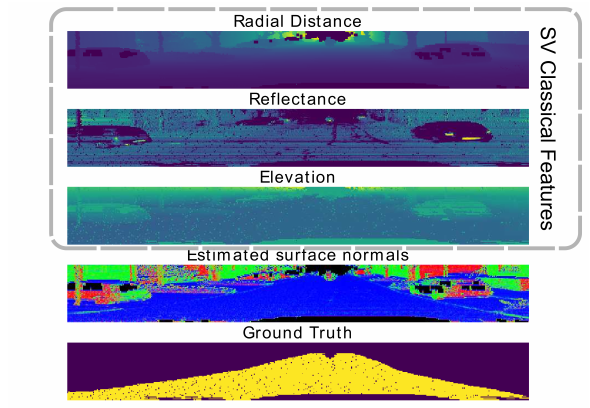
Figure 7. A crop example of features projected on the SV in case of a 64 layers scanner. Surface normals are estimated from radial distance image. The last image below is the ground truth for this